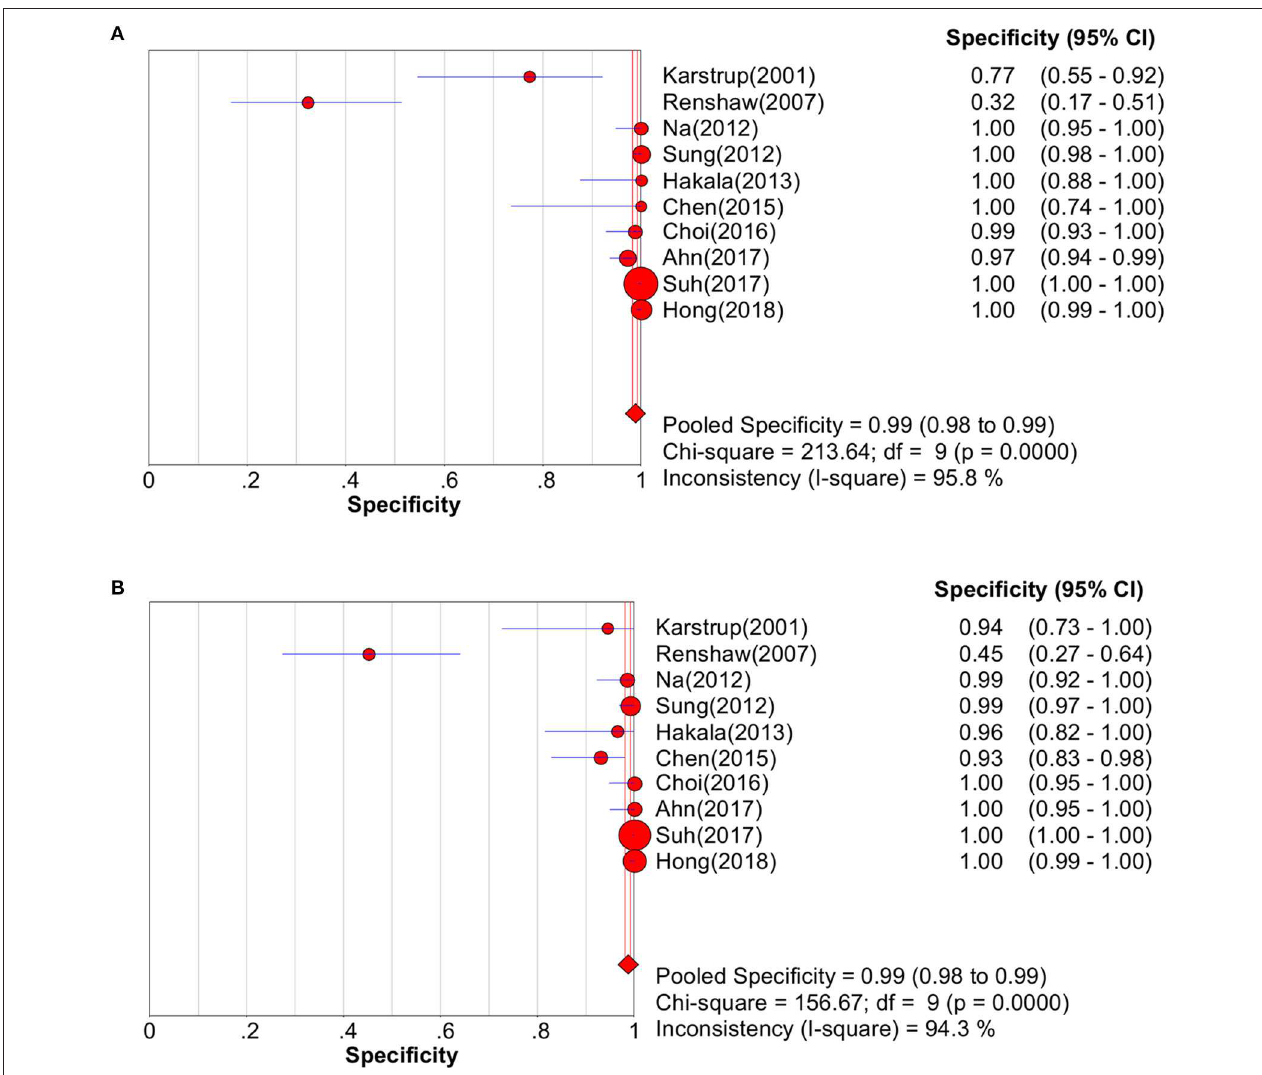
FIGURE 4 | Pooled specificity forest plot of two methods in diagnosing thyroid cancer. (A) FNA; (B) CNB.